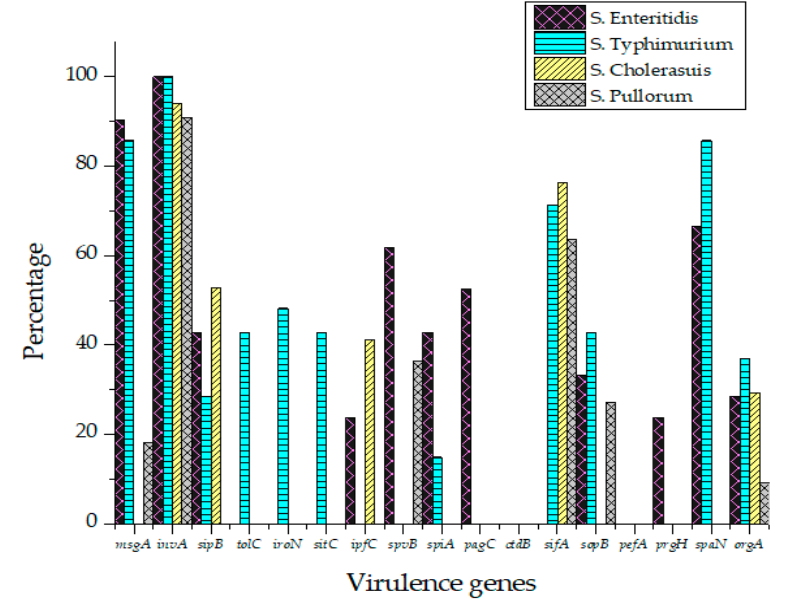
Figure 2. Prevalence of virulence factors in S . Enteritidis, S . Typhimurium, S . Pullorum and S . Choleraesuis.